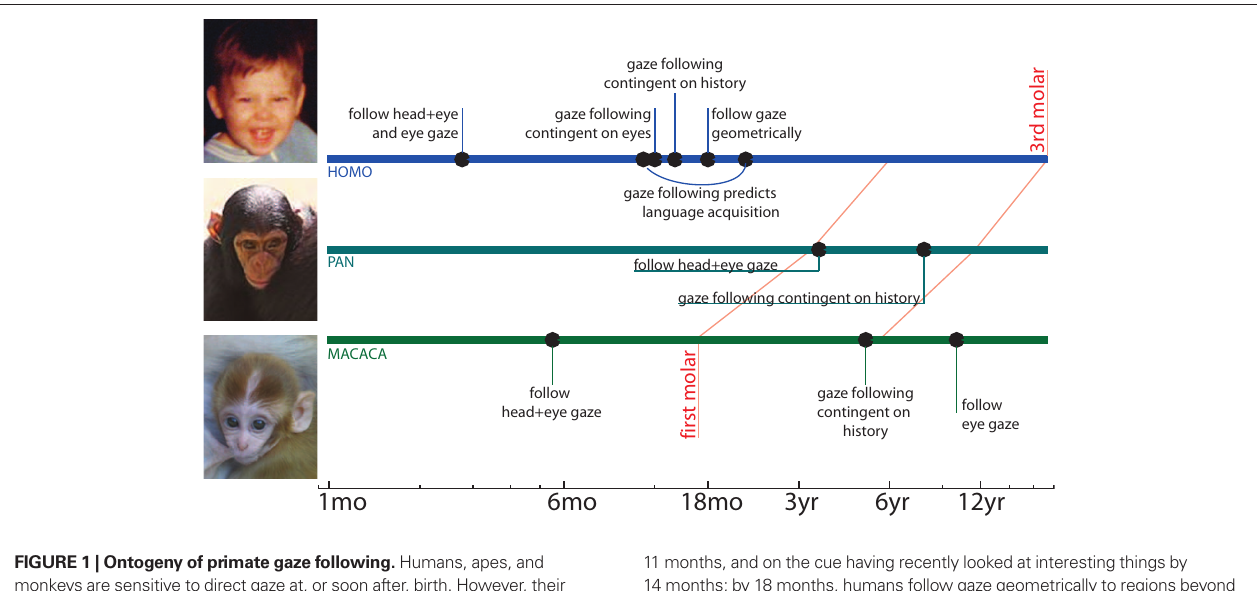
FIgure 1 | Ontogeny of primate gaze following. Humans, apes, and monkeys are sensitive to direct gaze at, or soon after, birth. However, their understanding of deictic gaze develops during childhood. Human gaze following arises early in life, with responses to turned heads and averted eyes arising between 2–6 months; gaze following at 10–12 months predicts language acquisition over the next year. Near the 1-year mark, human gaze following becomes more sophisticated: it is contingent on cue’s eyes being open at